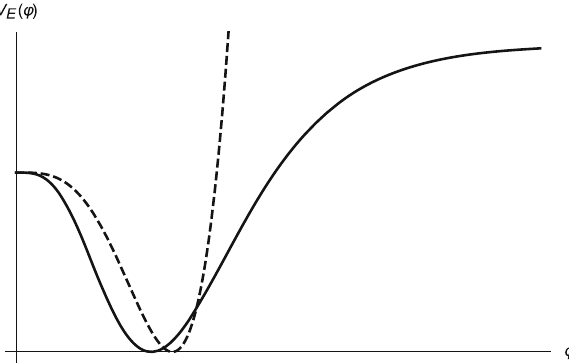
Fig. 1 Thedashedlinedenotes theCWpotentialinSVmodel. Thefull line indicates the shape of the potential obtained in (37) which comes from the insertion of conformal symmetry in SU(5). When ϕ (cid:5) μ the above VEV (AV) branch of the potential approaches the plateau of Starobinsky model